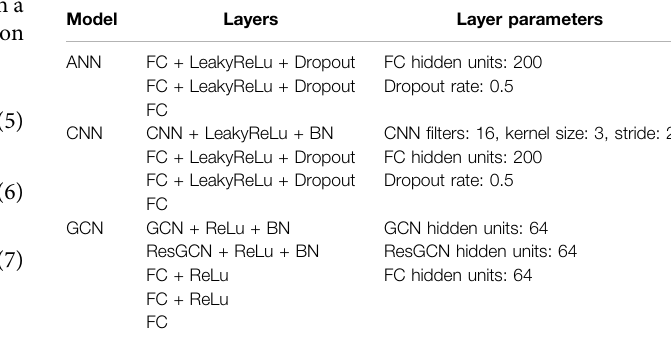
TABLE 1 | Architectures of the ANN, CNN,and GCN